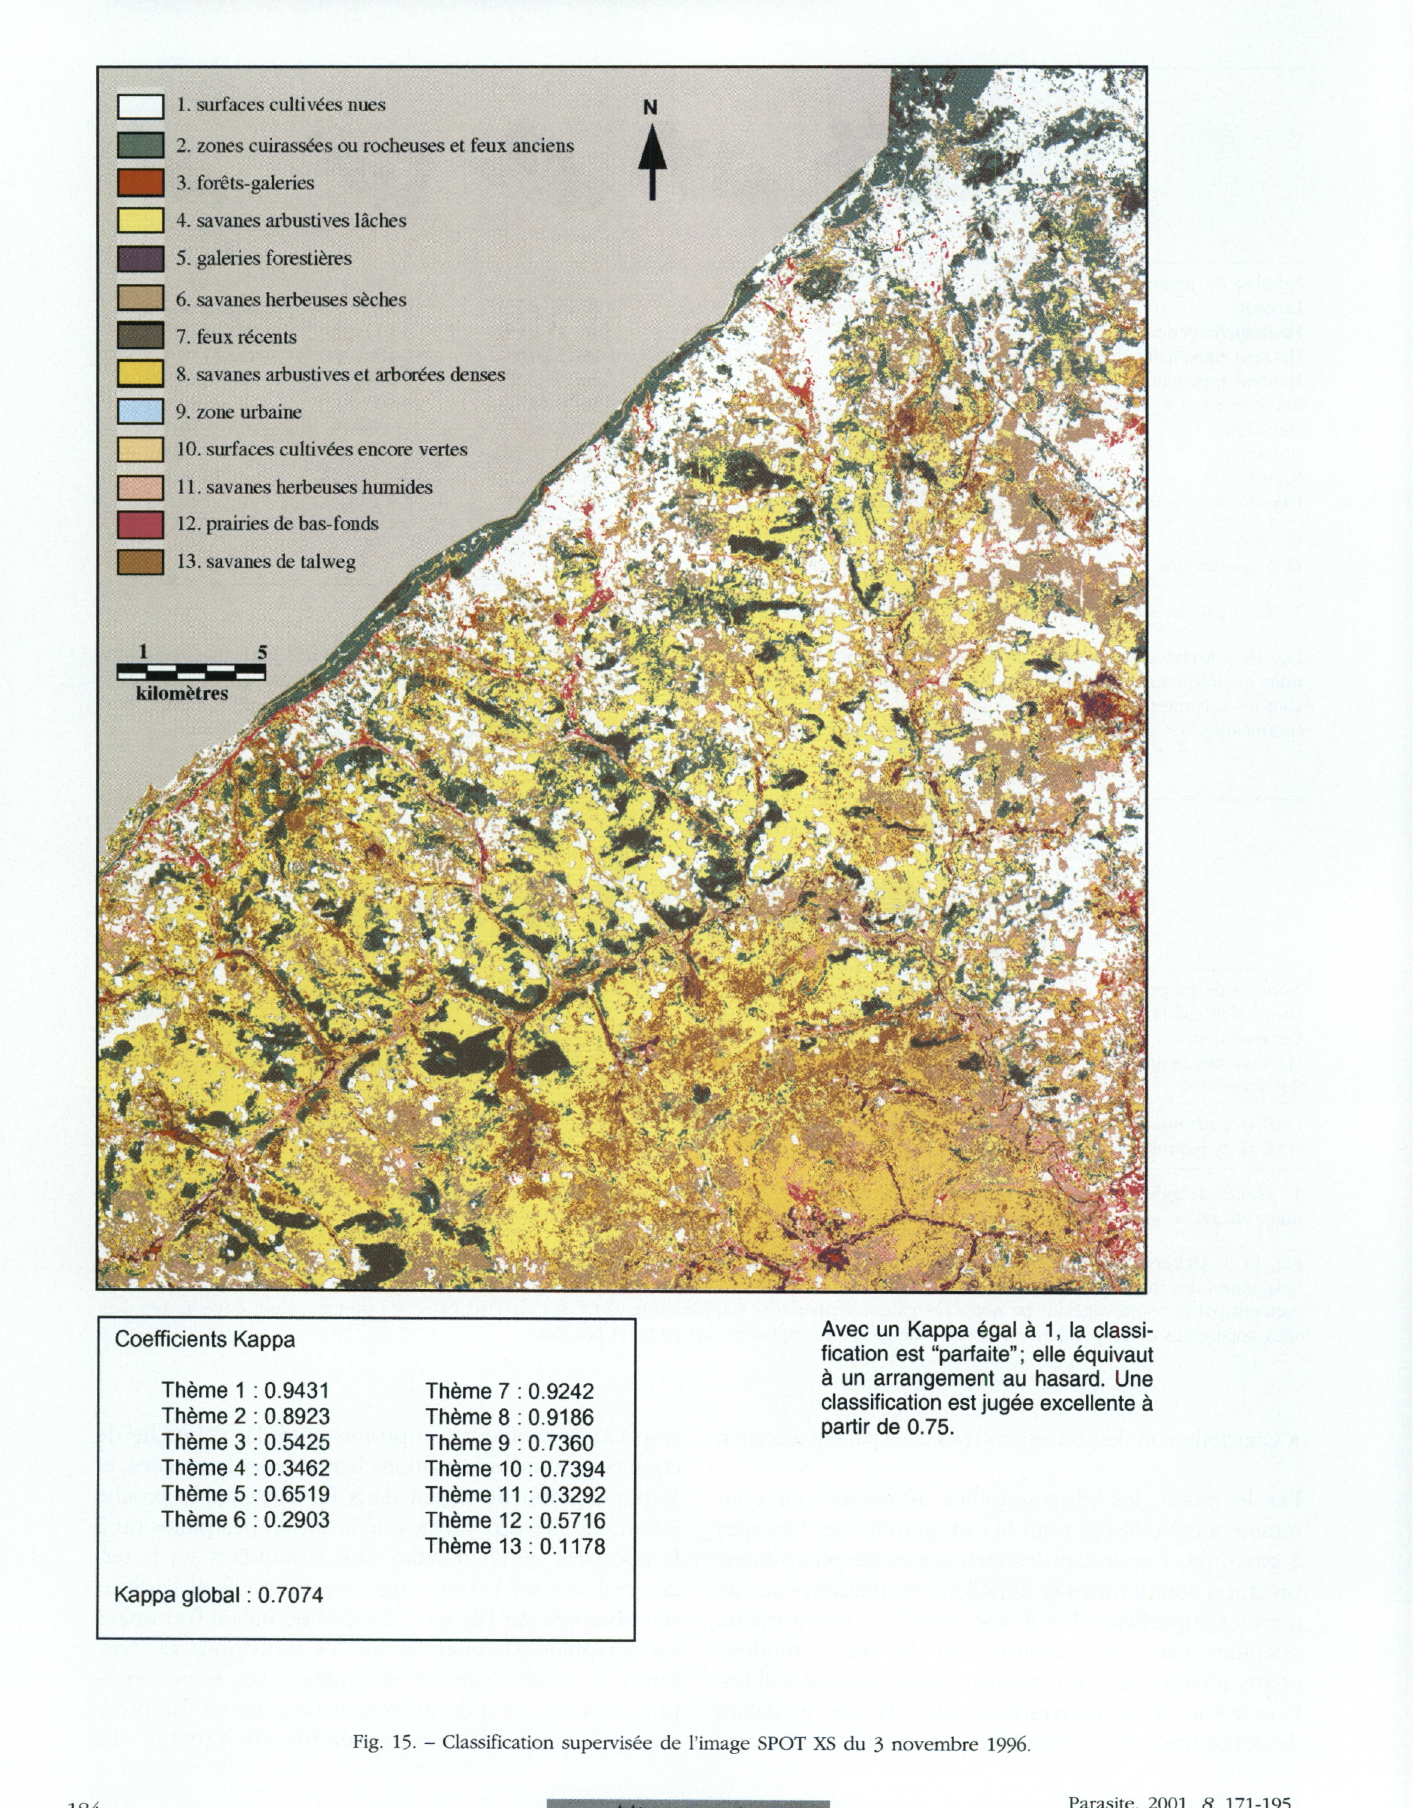
Fig. 15. - Classification supervisée de l’image SPOT XS du 3 novembre